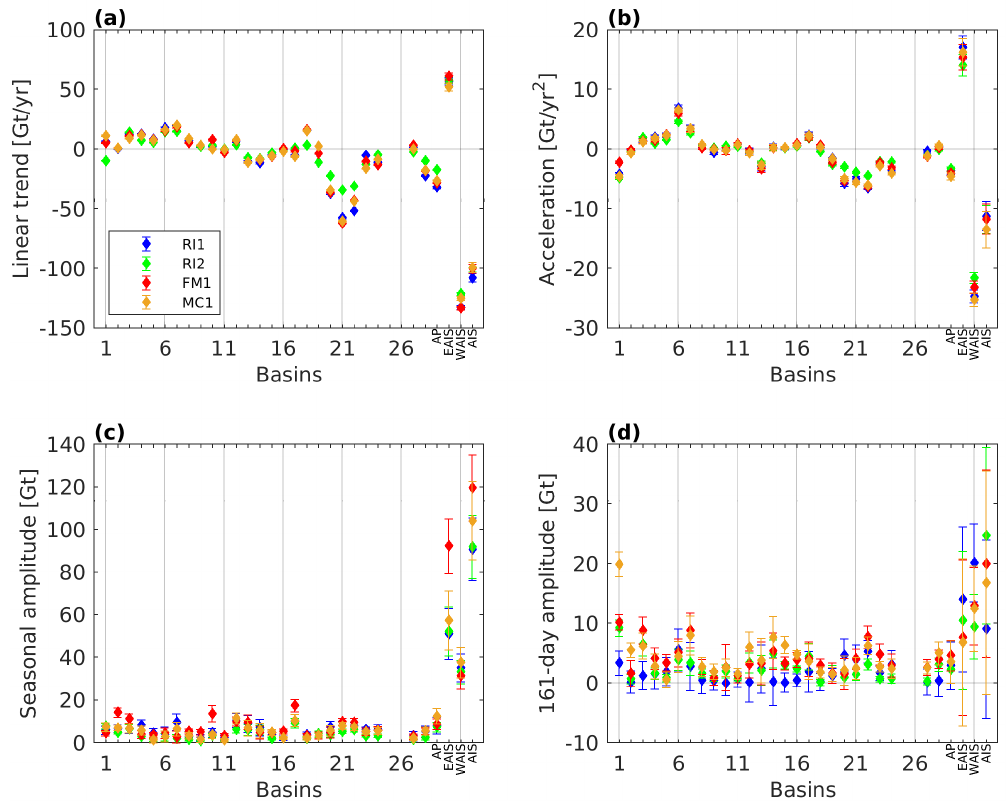
Figure 4. Temporal changes in ice mass for all AIS basins and aggregations, derived using a consistent linear, periodic (1yr, 1/2yr, 161/365.25yr) and quadratic model for all time series: ( a ) linear trend, ( b ) acceleration, ( c ) seasonal amplitude, ( d ) 161-day period, including the formal errors from the least squares